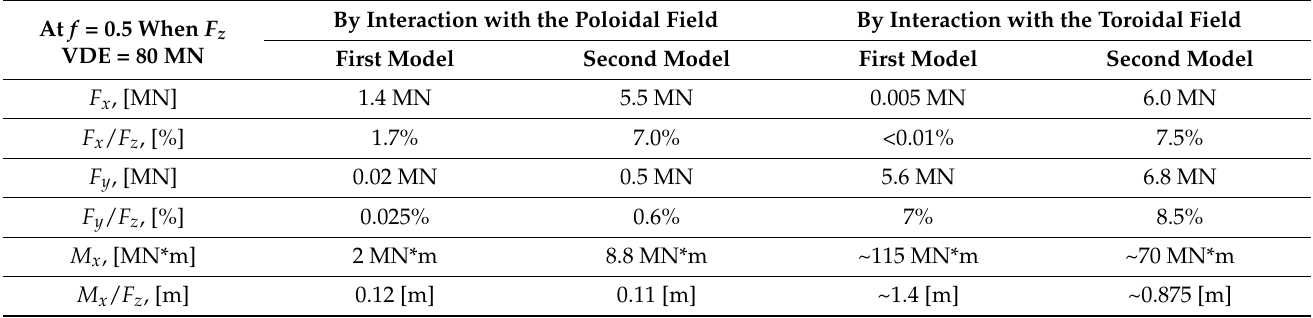
Table 1. Peak lateral forces ( F x and F y ) and lateral torque ( M x ) at VV (with blanket and divertor) due to only the anti-symmetric halo current component obtained at assumed fraction of anti-symmetric halo current density f = 0.5, and their percentage of the maximum vertical force at either at VV or at the Magnets ( ≈ 80 MN) calculated for the corresponding symmetric